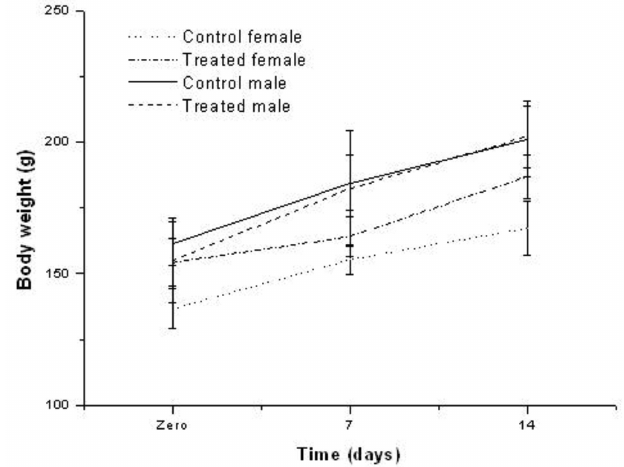
FIGURE 4 - Changes in rat body weight during atranorin (ATR) treatment (5 g/kg-single dose). Each point represents mean ± standard deviation (SD) of n = 10.